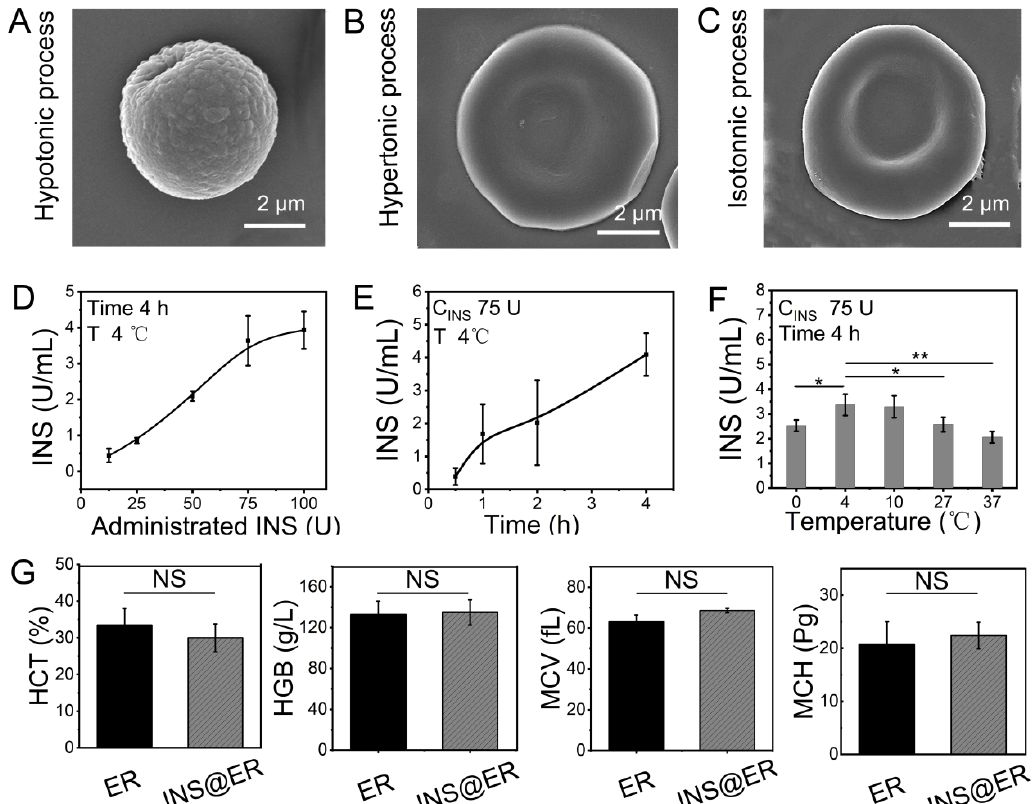
Figure 1. The construction of INS@ERs in the INS reactor. ( A ) SEM image of an ER in hypotonic process. ( B ) SEM image of an ER in hypertonic process. ( C ) SEM image of an ER in isotonic process. ( D ) The relationship between administrated INS content in the INS reactor and loading concentration in the INS@ERs. ( E ) The change curve of INS concentration in the INS@ERs with the hypotonic time. ( F ) The plot of the relationship between hypotonic temperature and INS concentration. * indicates p < 0.05, ** indicates p < 0.01, and NS indicates p > 0.05 with comparison between groups. ( G ) Hematological parameters of native ERs and INS@ERs, including HCT, HGB, MCV, and MCH. NS indicates non-significance.